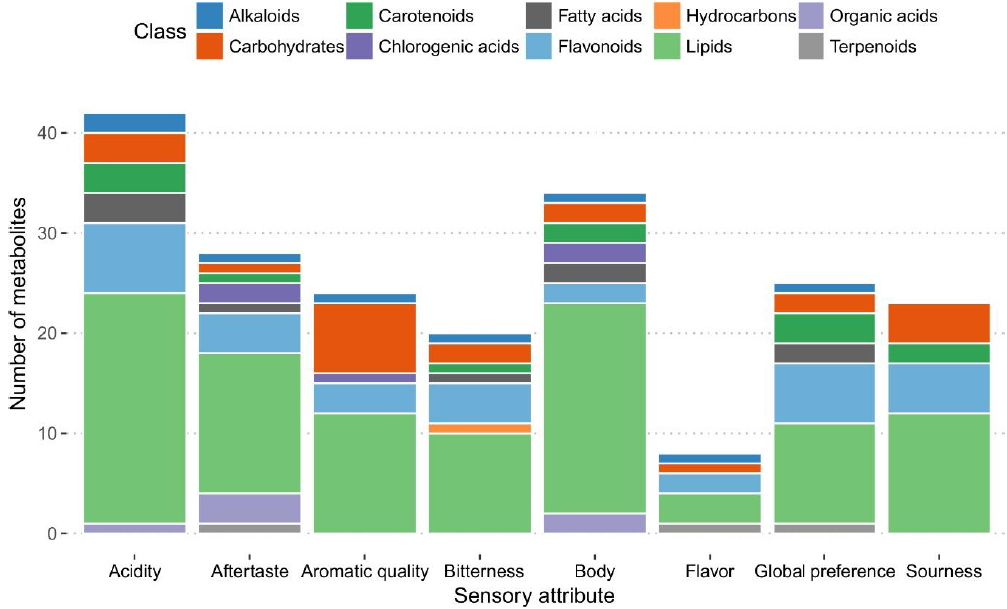
Figure 5. Classification of roasted bean metabolites linked to sensory traits of coffee beverage. Only putatively identified metabolites were included for compound classification by using KEGG and Pubchem tools.